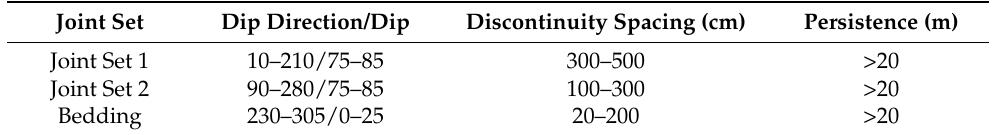
Table 3. Values of orientations, discontinuity set spacing, and persistence obtained by in situ tradi- tional geological and geotechnical